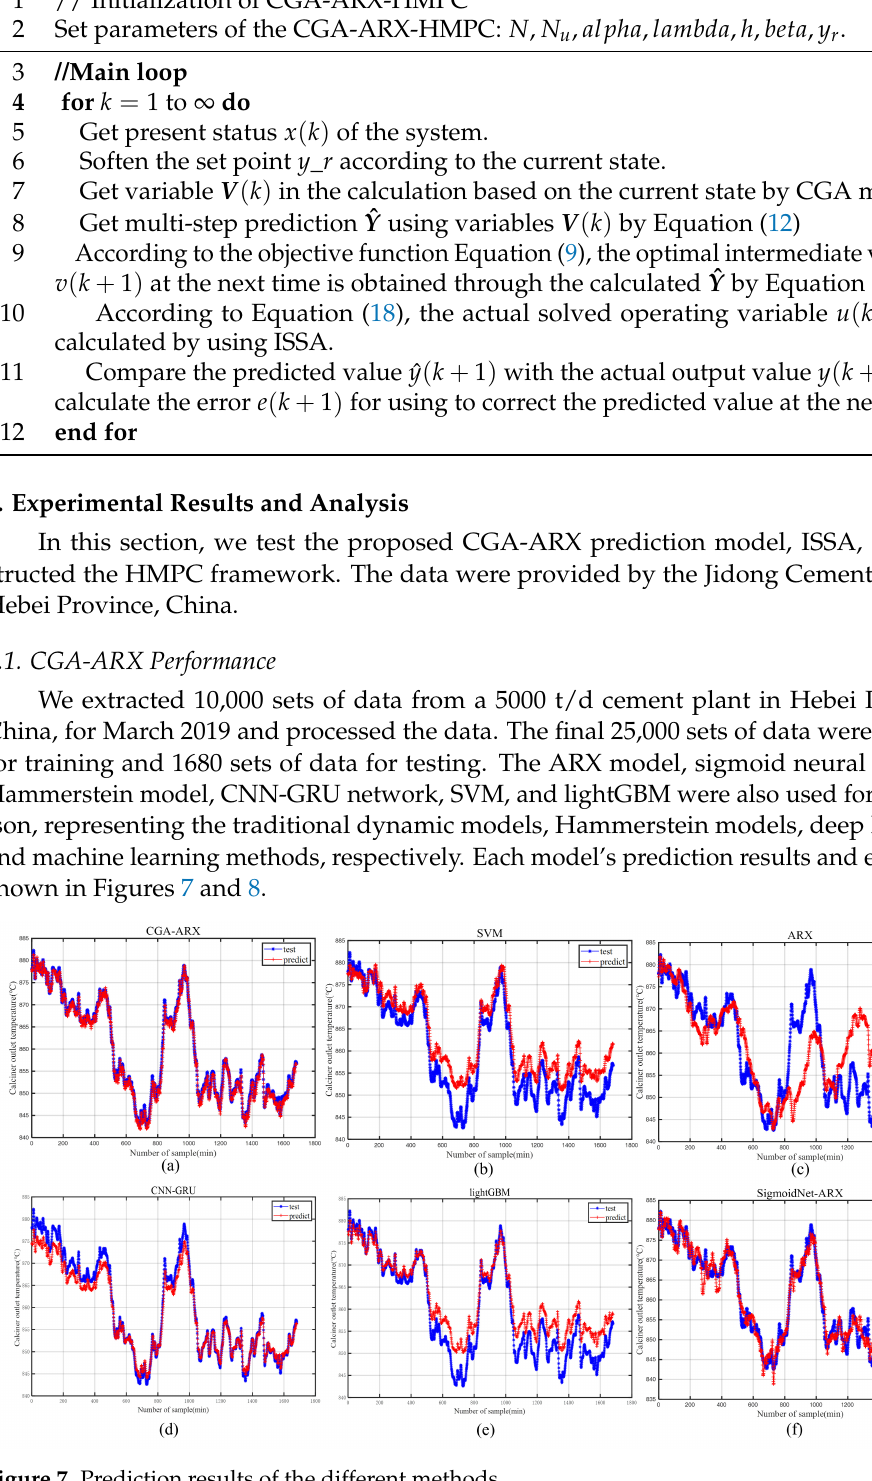
Figure 7. Prediction results of the different